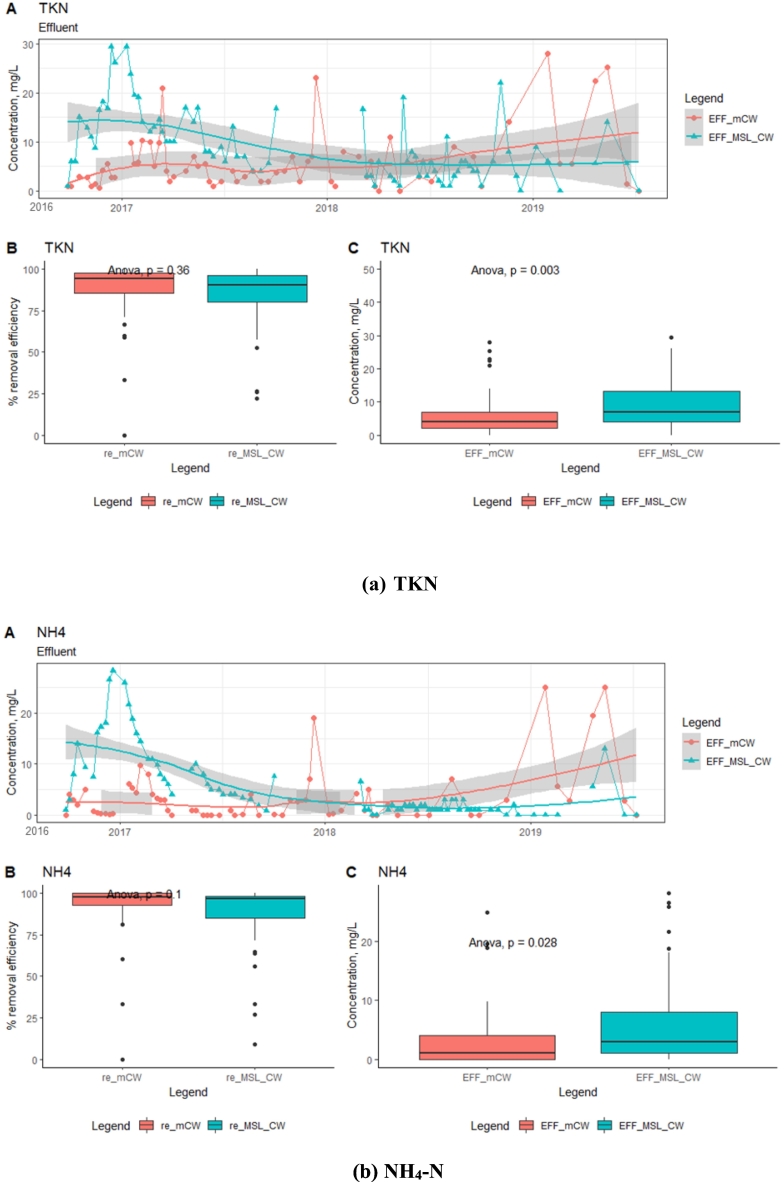
Time-series analysis of effluent concentrations and box plots (removal efficiency (re) and concentration (EFF)): TKN, NH4-N and TP.